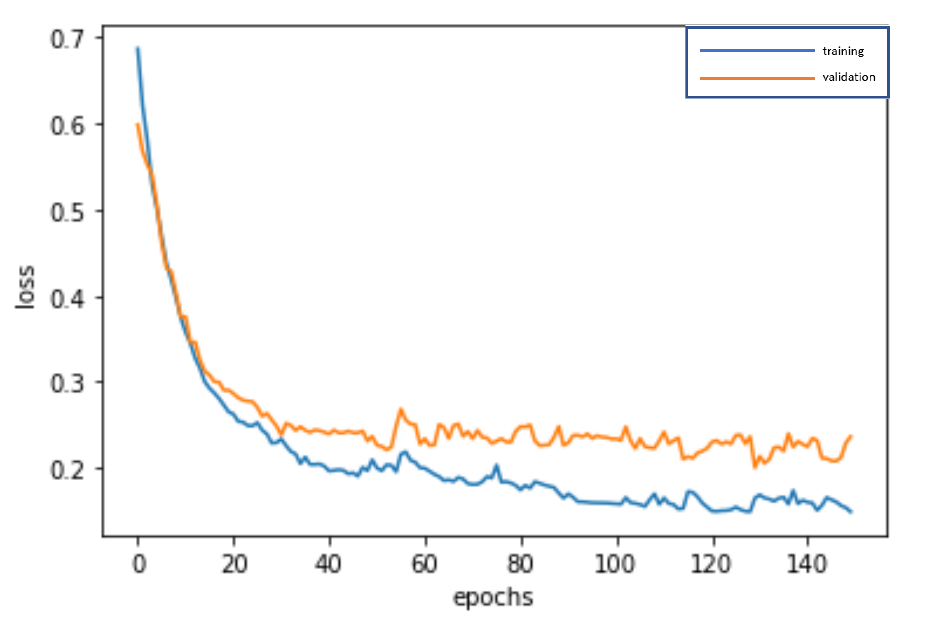
Figure 8. Graph of loss function of the CART-RNN modeling.